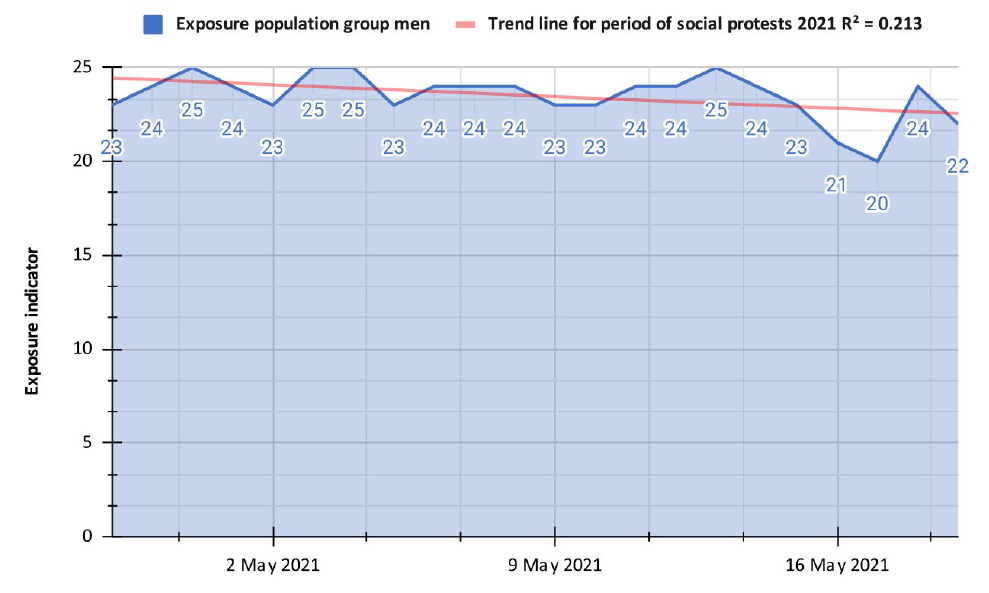
Figure 5. Exposure indicator for the period of social protests in 2021 in